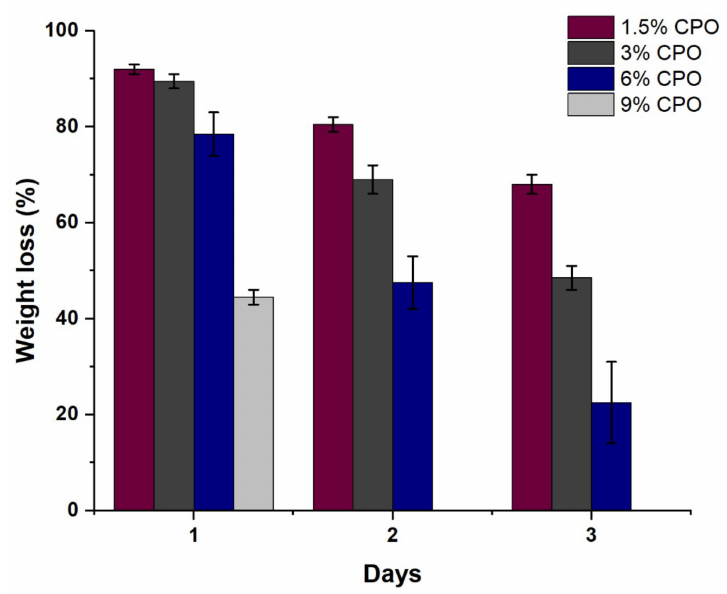
Figure 3. The weight loss percentage of samples over a three-day period ( n =